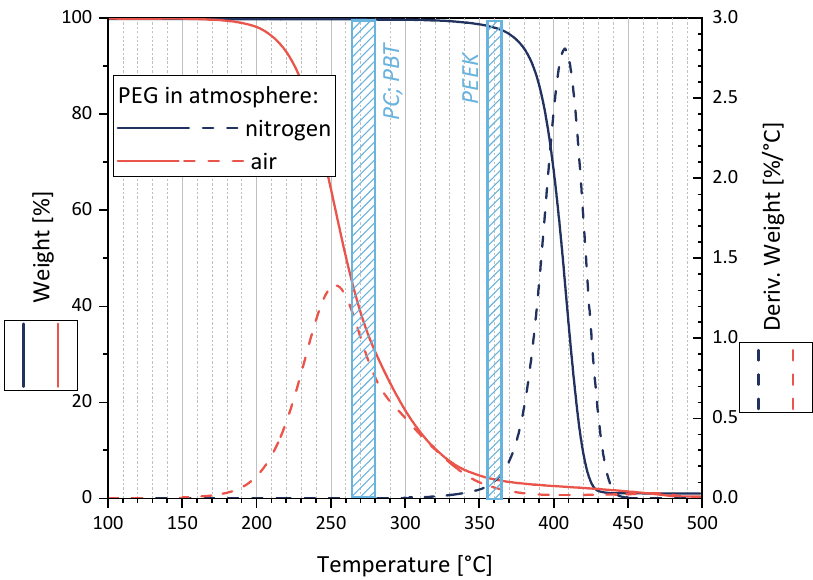
Figure 3. Thermal degradation behavior of PEG as studied by TGA in air and nitrogen atmosphere. The processing temperature ranges for the matrix polymers PC, PBT, and PEEK are marked as blue areas.